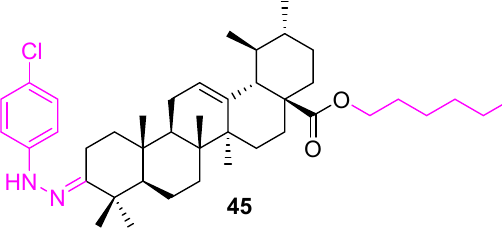
Figure 30. Structure of 45 .